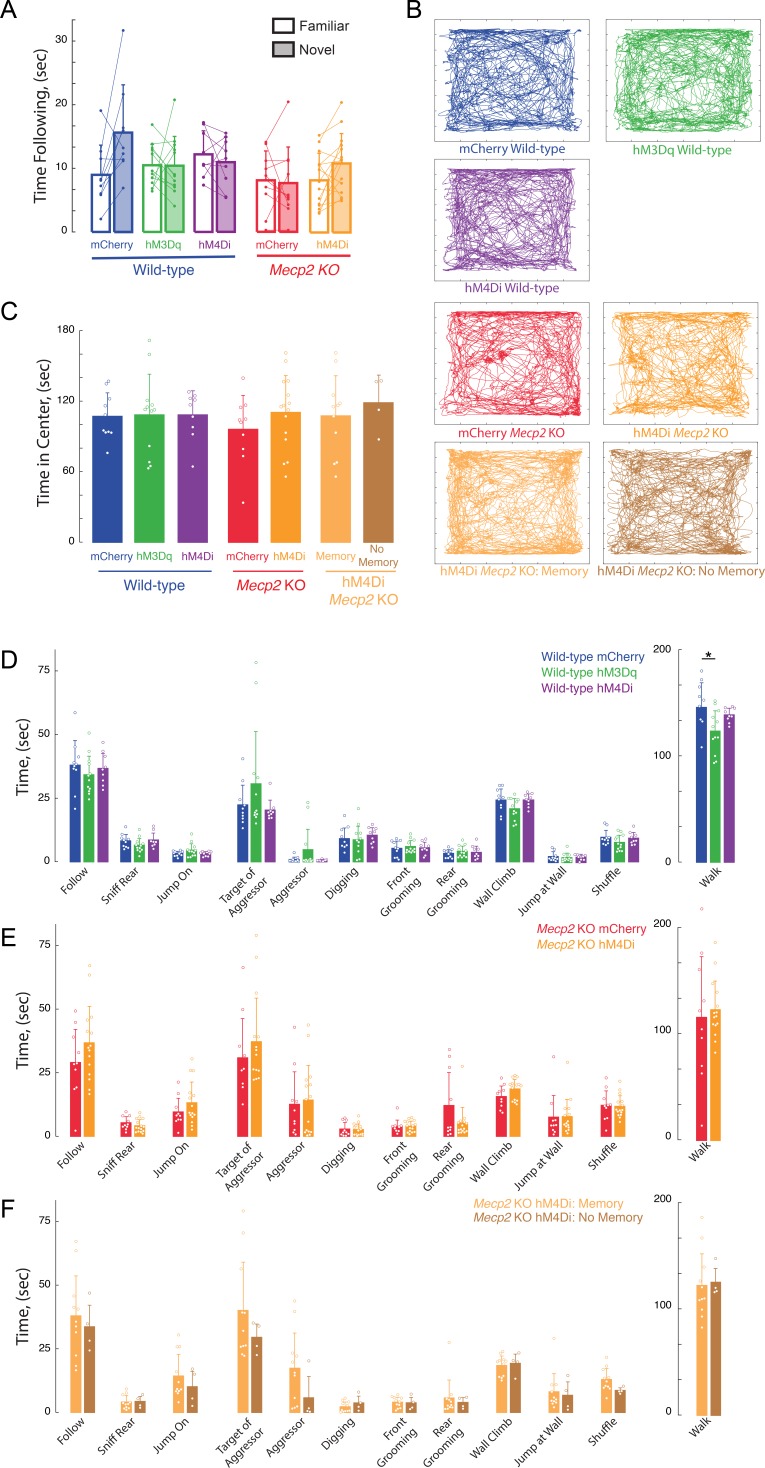
Lack of effects of long-term DREADD stimulation by CNO on anxiety and general (non-social memory) behaviors.(A) Total times spent following novel vs. familiar sentinels. (B) Representative tracks of individual trajectories of test mice during social encounters in an open field. (C) Average time spent in the center of the open field, as a measure of anxiety (mCherry vs. hM3Dq WT p>0.9999; mCherry WT vs. Mecp2 KO, p=0.9793; hM3Dq WT vs. mCherry Mecp2 KO, p=0.9566; mCherry vs. hM4Di WT, p>0.9999; hM4Di WT vs. mCherry Mecp2 KO, p=0.9695; hM3Dq WT vs. hM4Di WT p>0.9999; mCherry vs. hM4Di (All) Mecp2 KO, p=0.8910; hM4Di (All) Mecp2 KO vs. mCherry WT, p>0.9999; mCherry NAc vs. mCherry mPFC WT, p=0.9492; mCherry vs. hM3Dq NAc WT, p=0.9952; Memory vs. mCherry Mecp2 KO, p=0.9727; Memory vs. mCherry WT, p>0.9999; No Memory vs. mCherry Mecp2 KO, p=0.8493; No Memory vs. mCherry WT, p=0.9941; Memory vs. No Memory, p=0.9947; One-way ANOVA with Turkey’s multiple comparisons). (D–F) Time spent engaging in social, aggressive, general, and locomotor behaviors during the unrestricted social interaction assay in (D) DREADD-expressing WT mice, (E) Mecp2 KO mice, and hM4Di Mecp2 KO mice separated by memory performance (F) after long-term CNO treatment (n = 9 mCherry WT mice; n = 12 hM3Dq WT mice; n = 9 hM4Di WT mice; One-Way ANOVA or Kruskal-Wallis test dependent on normalcy; n = 10 mCherry Mecp2 KO; n = 15 hM4Di Mecp2 KO mice; Student’s t-test or Mann-Whitney test dependent on normalcy).10.7554/eLife.44182.024Figure 4—figure supplement 4—source data 1.Memory Discrimination correlates to vHIP input to the mPFC in Mecp2KO mice.